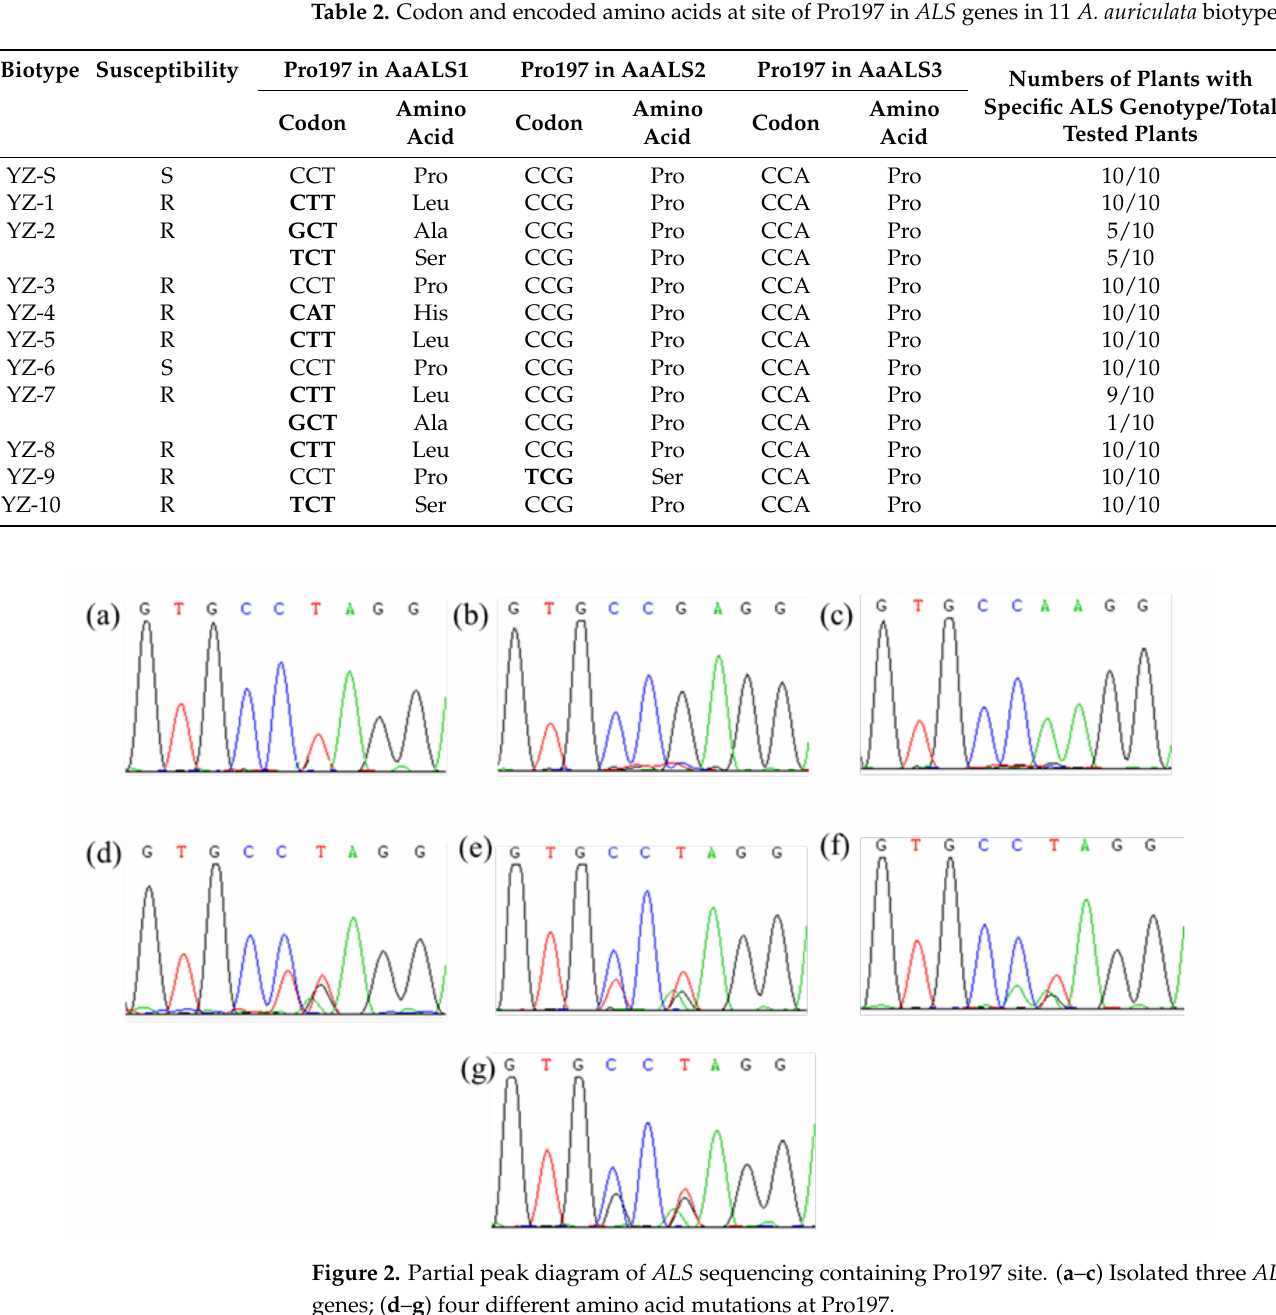
Table 2. Codon and encoded amino acids at site of Pro197 in ALS genes in 11 A. auriculata biotypes.